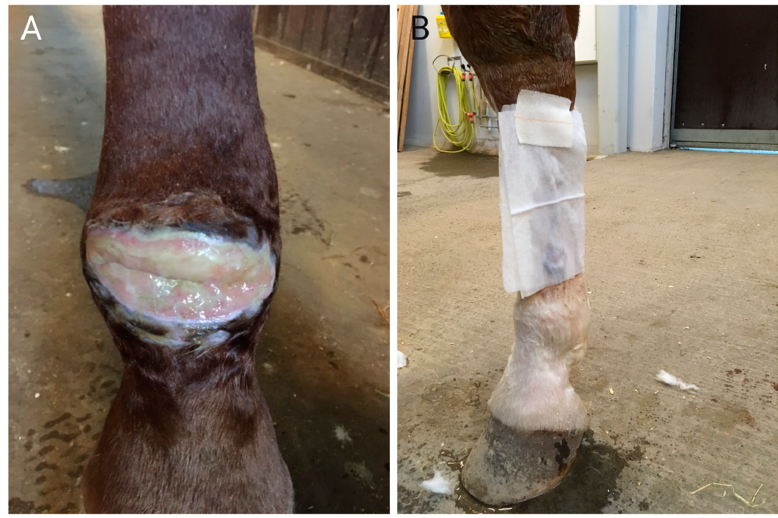
Figure 2. ( A ) Wound with exudate and presumed infection with biofilm. This wound will need reduction of bioburden to heal. This may be achieved by surgical debridement of the wound surface followed by topical application of antimicrobials (e.g., dressings containing cadexomer iodine, nanocrystalline silver, silver sulfadiazine, polyhexamethylene biguanide, or acetic acid). The treat- ment/dressing is reapplied at each bandage change, normally performed every 2 to 5 days. Reduc- tion of bioburden and removal of exudates may also occur through application of dressings con- taining hypertonic saline; these are applied daily for one or a few days, where after the wound is re- evaluated. When treating wounds with crevices in the wound surface, it is important to ensure deb- ridement of the crevice and to pack dressings into the crevice to ensure that the entire wound surface is in contact with the antimicrobial substance; ( B ) Application of acetic acid to a limb wound. Acetic acid soaked gaze is secured over the wound (cling wrap is applied on top to further secure), the gaze can be kept soaked by multiple applications of acetic acid (1–2%) over a 20–30-min treatment period. 6. Discussion Bacteria reside as biofilms in wounds, also equine wounds. The role biofilm play in wound healing seems to be depended on other factors than just the bacteria, mainly the wound bed and its microenvironment, including inflammatory capacity, oxygen condi- tions, and healing pattern [10,18,84]. The competent healing of equine body wounds seems to be unaffected by the presence of biofilms, whereas the inferior healing of limb wounds is further protracted by the presence of biofilm [18]. These observations are based on experimental wound studies in horses, whereas only few studies have detected biofilm in equine accidental wounds. The true prevalence of biofilm in equine naturally occurring limb wounds is unknown, as optimal detection methods have not been used so far and few studies exist. From our experimental study, the prevalence of biofilm infection seems to be around 100% in equine limb wounds [17]. Further studies, employing the gold stand- ard methods of biofilm detection, are essential to know the true prevalence and the con- sequences of biofilms in equine limb wounds. Due to these findings of biofilms in equine limb wounds and the similarity to human chronic wounds, biofilms should be suspected in equine limb wound healing with de- layed healing despite appropriate treatment. Debridement is the most effective therapy against biofilm in wounds, and fortunately, debridement is a well-established method in equine wound care, whereby exuberant granulation tissue can be debulked and the sur- face of infected/inflamed granulation tissue excised. This procedure will in most cases re-